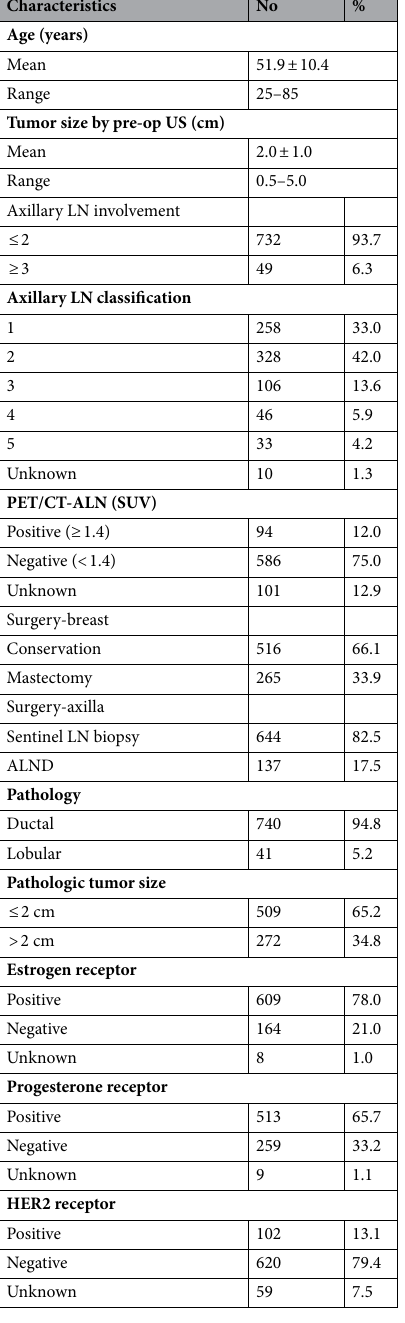
Table 4. Patient characteristics of the validation set (N = 781). Pre-op , Preoperative; US , Ultrasonography; LN , Lymph node; ALN , Axillary lymph node; PET/CT , Positron emission tomography/computed tomography; ALND , Axillary lymph node dissection; HER2 , Human epidermal growth factor receptor